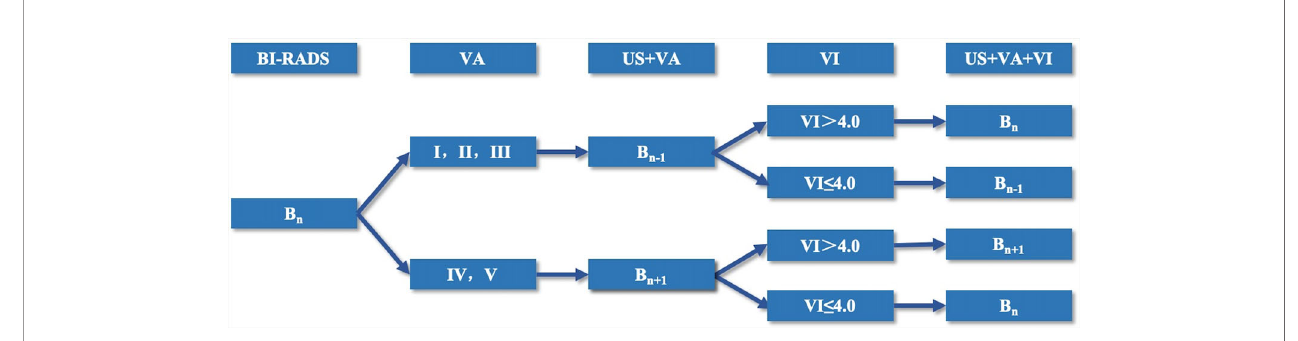
FIGURE 3 | Flow chart of the adjustment mode of category BI-RADS 4